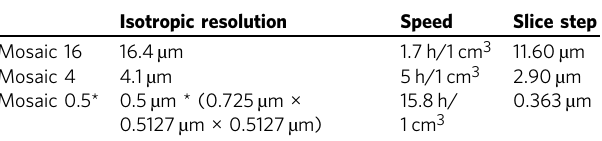
Table 2 Resolution, imaging speed and slice step for Mosaic 16, 4 and 0.5 ct-dSPIM scans,